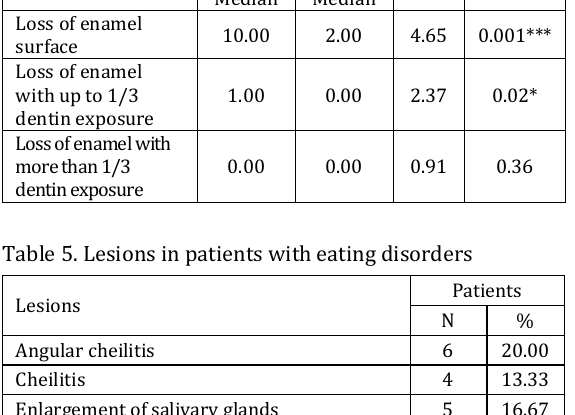
Table 2. PI, API, and OHI index in patients and controls Variables